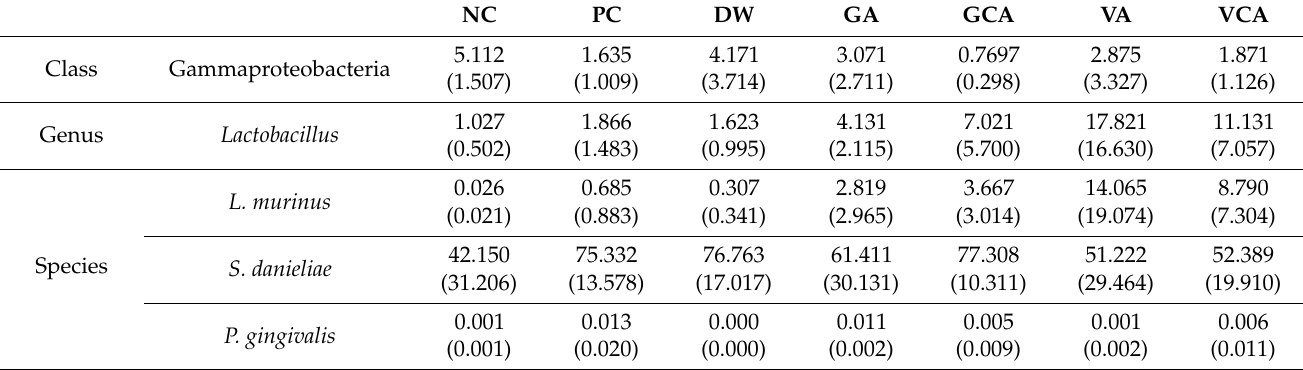
Table 2. The proportions of bacteria expressed as means and standard deviations in parenthesis at the genus and species